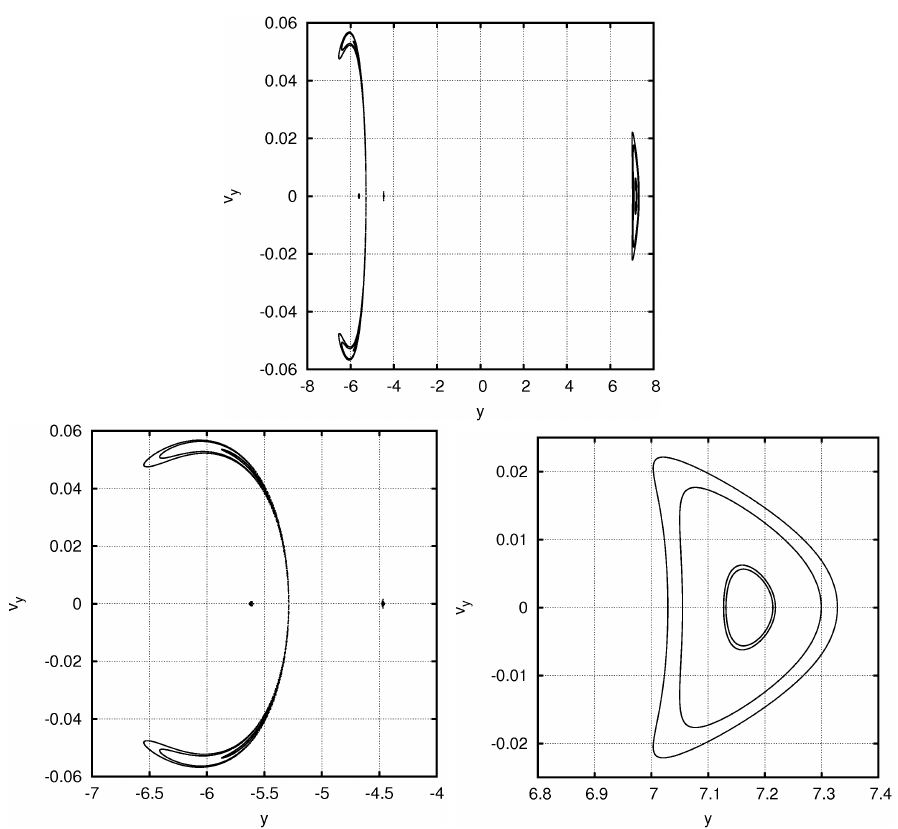
Fig. 10. Poincar´e map produced with the truth model parameters (top) with closeups of the structure for y < 0 (bottom left) and y > 0 (bottom right). was done sequentially over all trajectories of a single run at once. The results are shown in Figures 11, 12 and